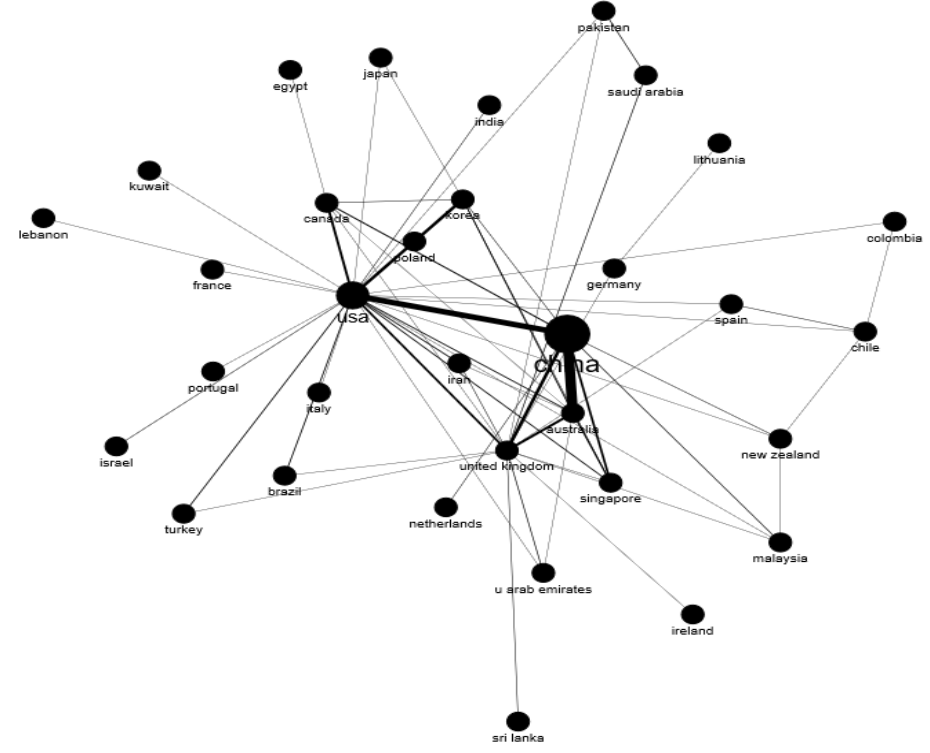
Figure 5. Country collaboration network from 2000 to 2020 (generated by Bibliometrix R ).